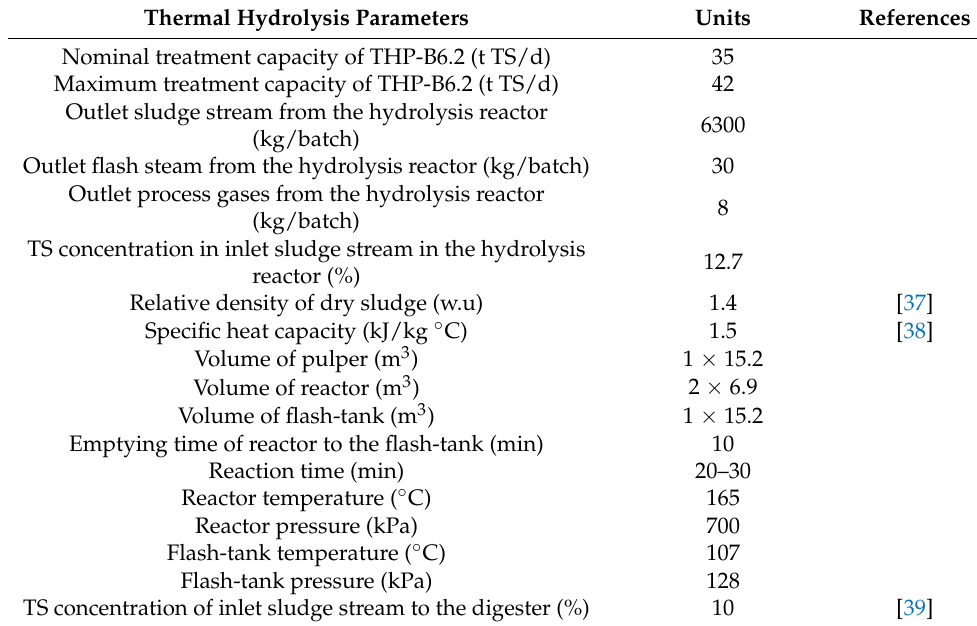
Table 3. Parameters of the modern wastewater treatment plant (WWTP). Technical characteristics of units operating in the different WWTP sections that are common to all scenarios